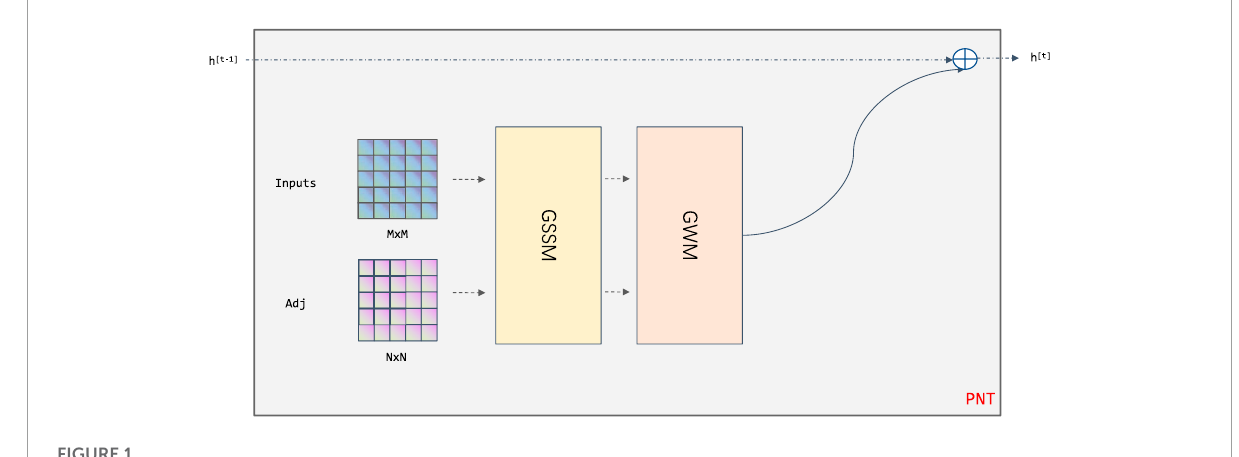
FIGURE 1 Internal structure of the PNT model.